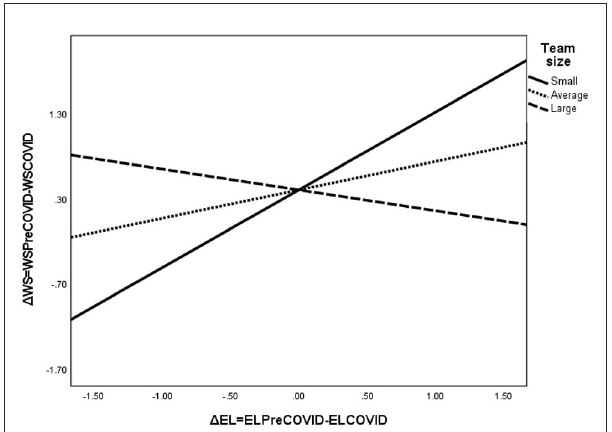
FIGURE3 The interaction effect between change in leadership support and the team size on work satisfaction. 1 LS, change in